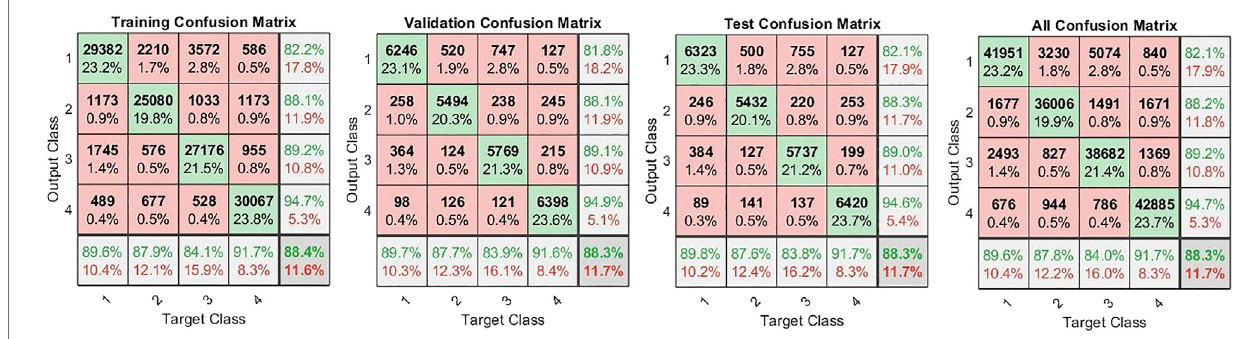
FIGURE 7 | Confusion matrix with maximum classi fi cation accuracy.